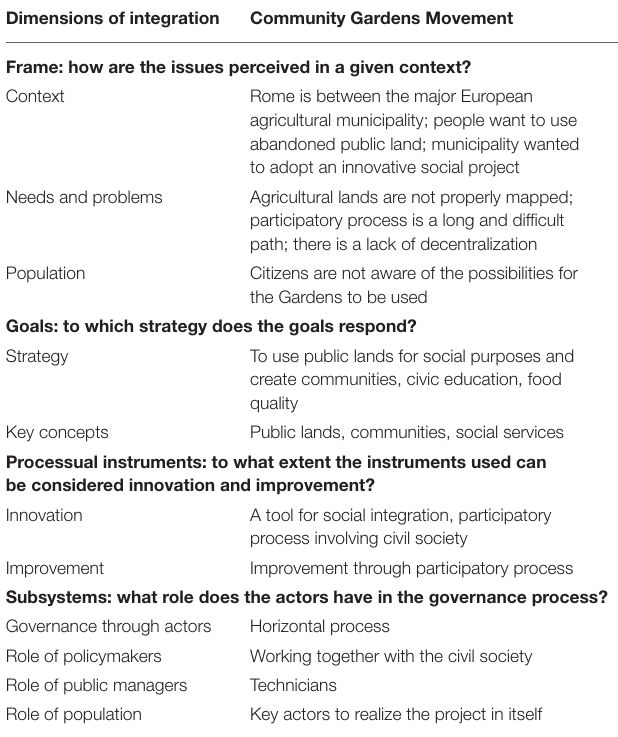
TABLE 5 | Summary of community gardens movement process through framework (source: authors). Dimensions of